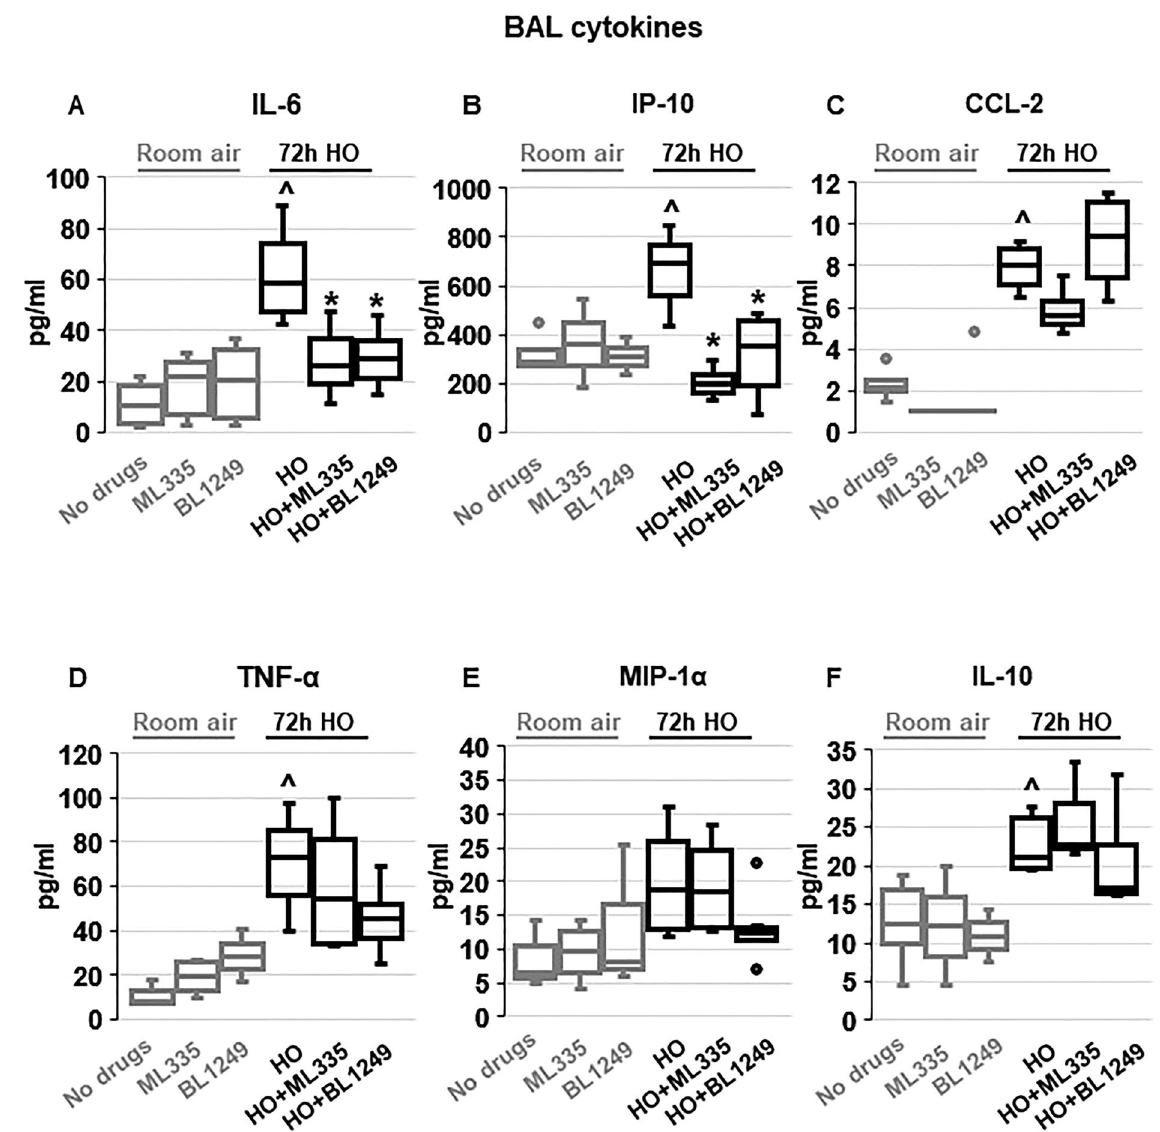
Figure 2. Effects of ML335 and BL1249 on BAL fluid cytokine concentrations ( A – F ): HO exposure increased IL-6, IP-10, CCL-2, TNF-α, and IL-10 concentrations, but not MIP-1α. Once-daily i.t . treatment with ML335 or BL1249 decreased HO-induced IL-6 and IP-10 levels, but not CCL-2, TNF-α or IL-10. Data are represented as Box-Whisker plots with medians, 1st and 3rd quartiles, and max and min values; n = 5–9; ^compared to mice exposed to room air and treated with a vehicle control (no drugs), *compared to HO exposed mice; p ≤